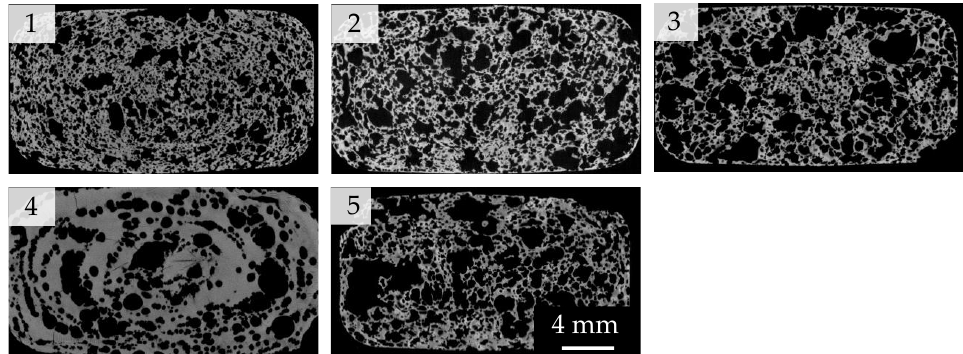
Figure 2. Structure of sintered Freeze Foams (1-W34D0T5P2; 2-W34D0T23P2; 3-W34D0T23P6; 4-W34D3T23P6; 5-W48D0T23P2) via